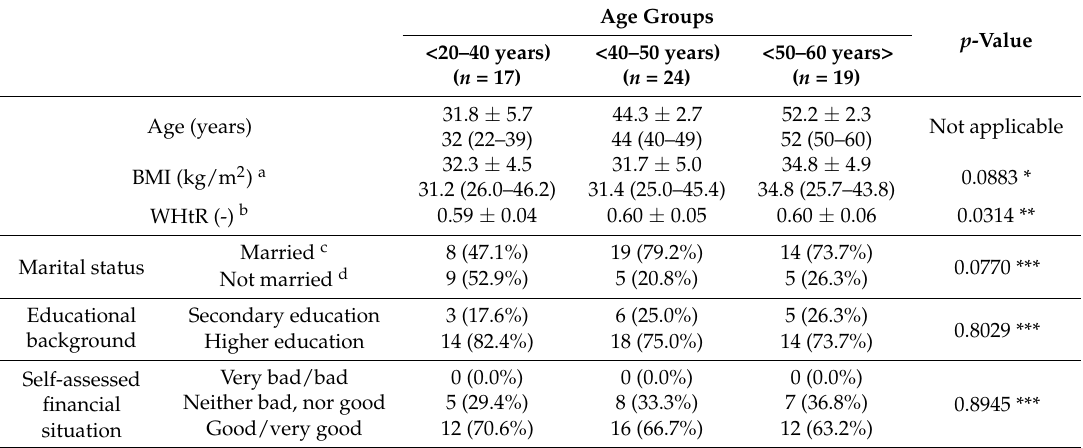
Table 1. The characteristics of the studied group for the sub-groups stratified by